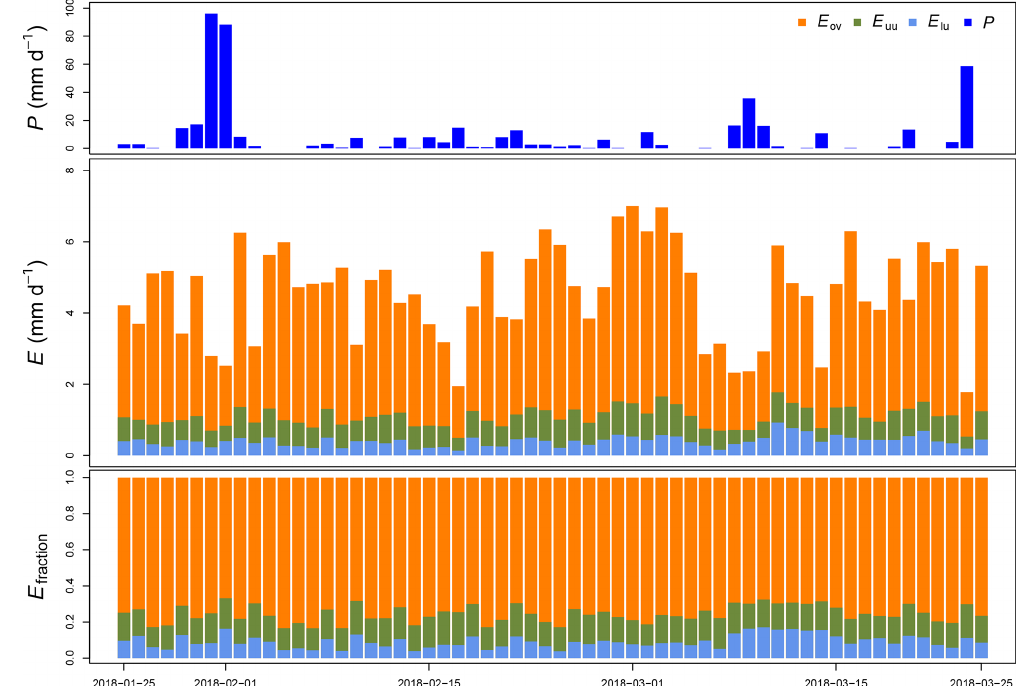
Figure 5. Measured precipitation ( P ), estimated evaporation ( E ) and its fraction ( E fraction ) per canopy layer at La Selva Biological Station (LSBS) during the monitoring period from 25 January to 25 March